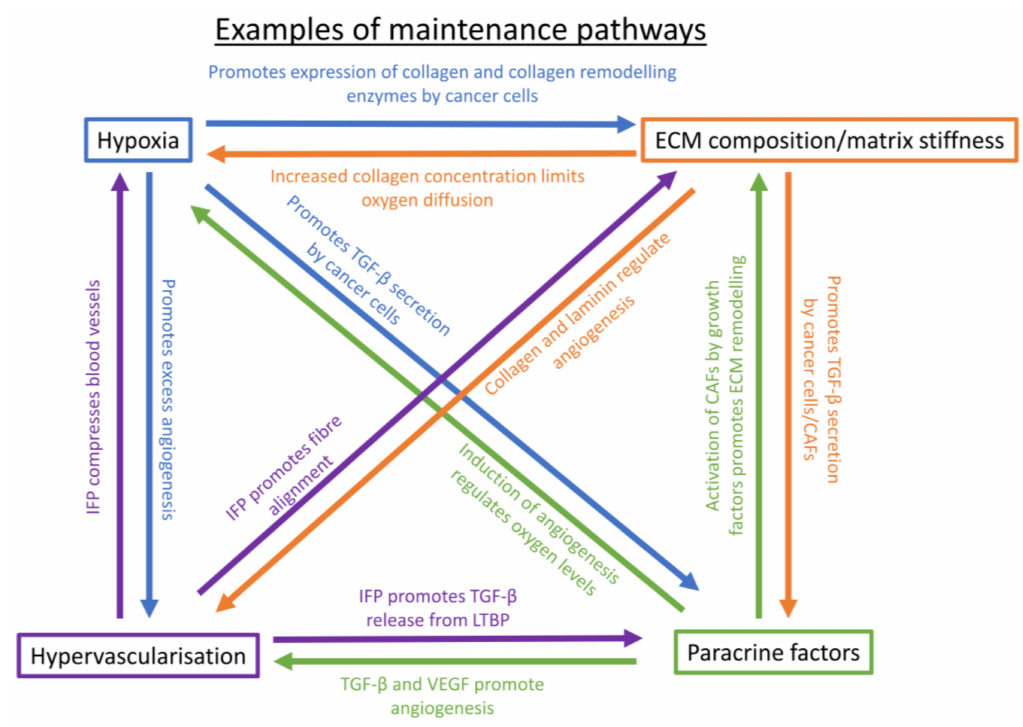
Figure 4. Examples of environment maintenance pathways. Blue = hypoxia-induced. Orange = ECM composition/matrix stiffness induced. Green = Paracrine factor induced. Purple = hypervascularization induced. TGF- β = transforming growth factor beta, IFP = interstitial fluid pressure, CAFs = cancer-associated fibroblasts, LTBP = latent TGF- β -binding protein, VEGF = vascular endothelial growth factor, ECM = extracellular